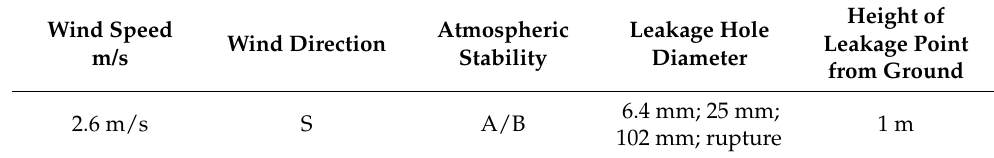
Table 12. Initial parameter of the model.